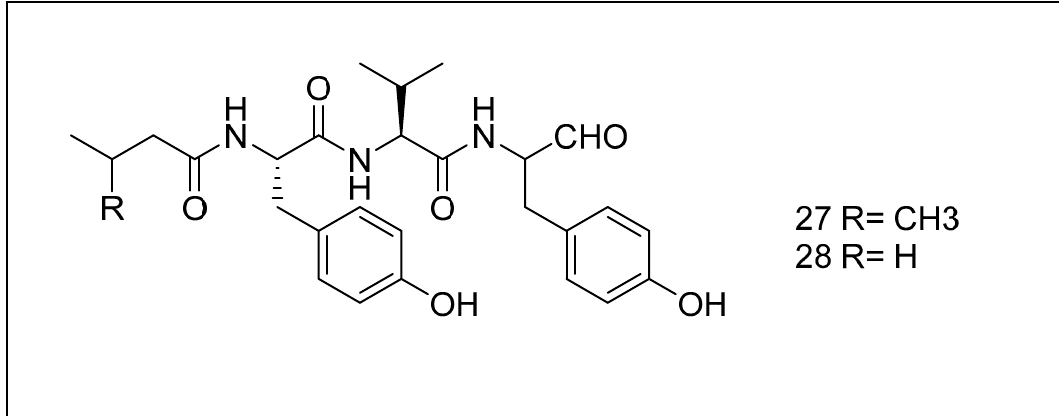
Figure 11. Chemical structures of tyropeptin A ( 27 ) and tyropeptin B ( 28